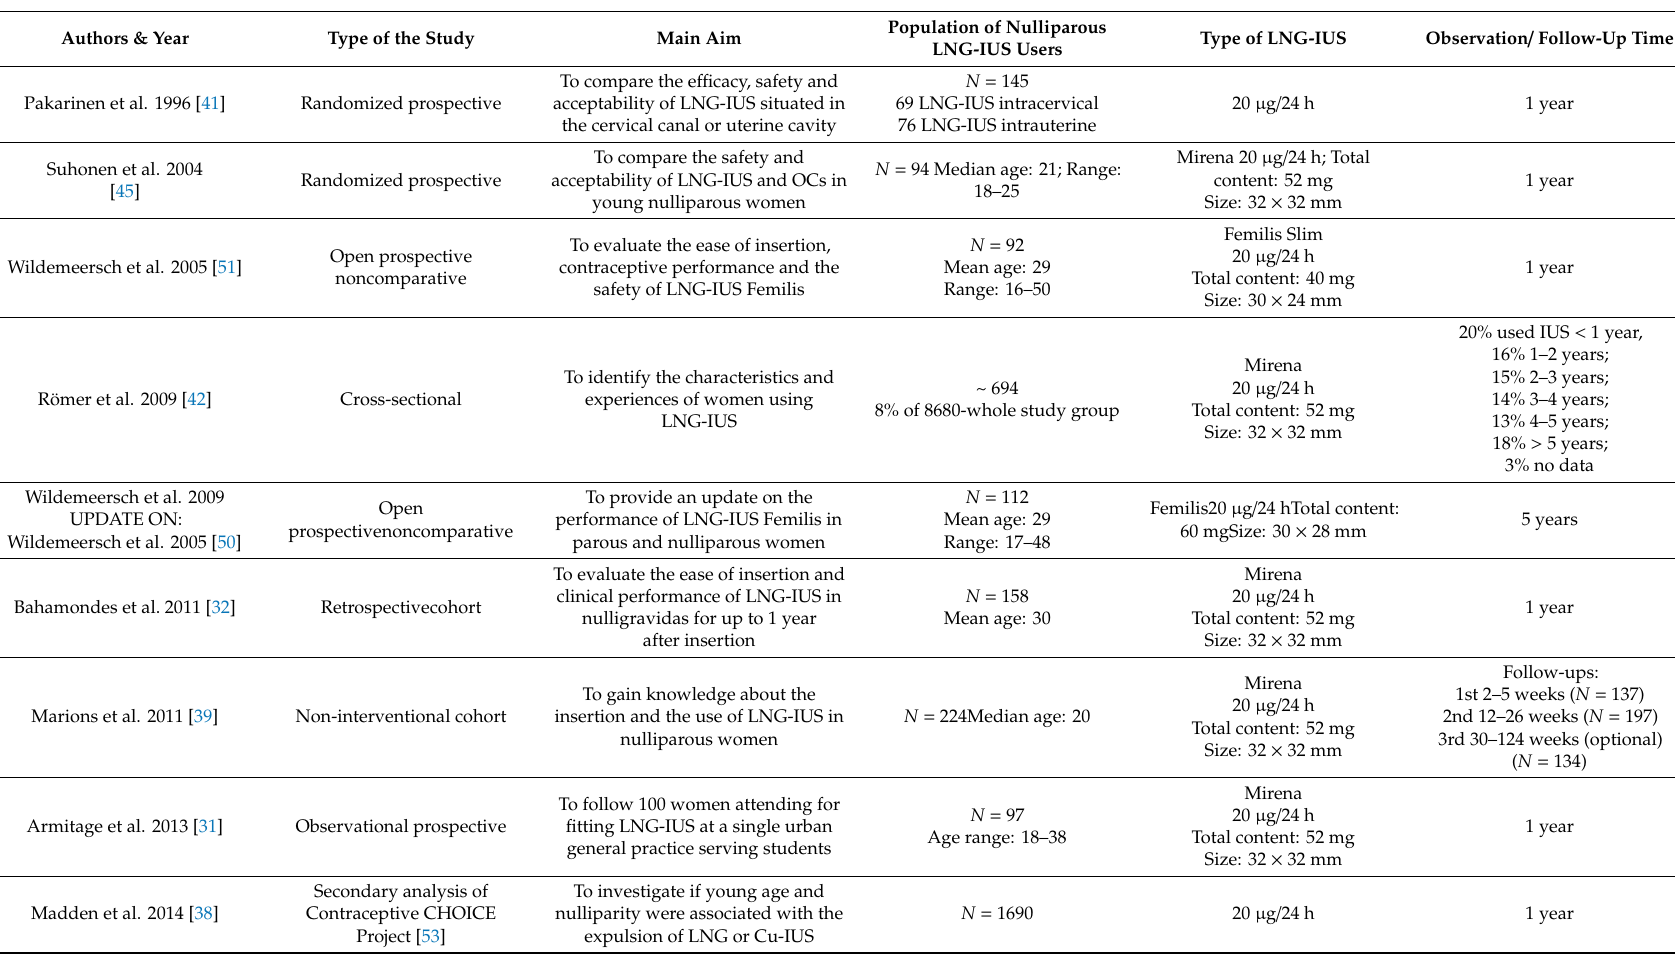
Table 2. Characteristics of the studies included in the systematic